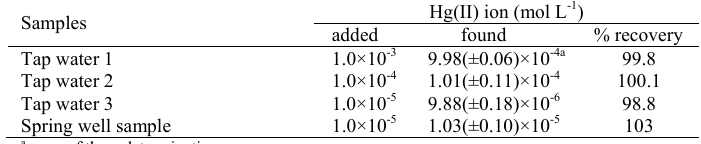
Table 3. Determination of Hg 2+ content in different real samples. The experimental conditions are as in Fig. 7. Samples